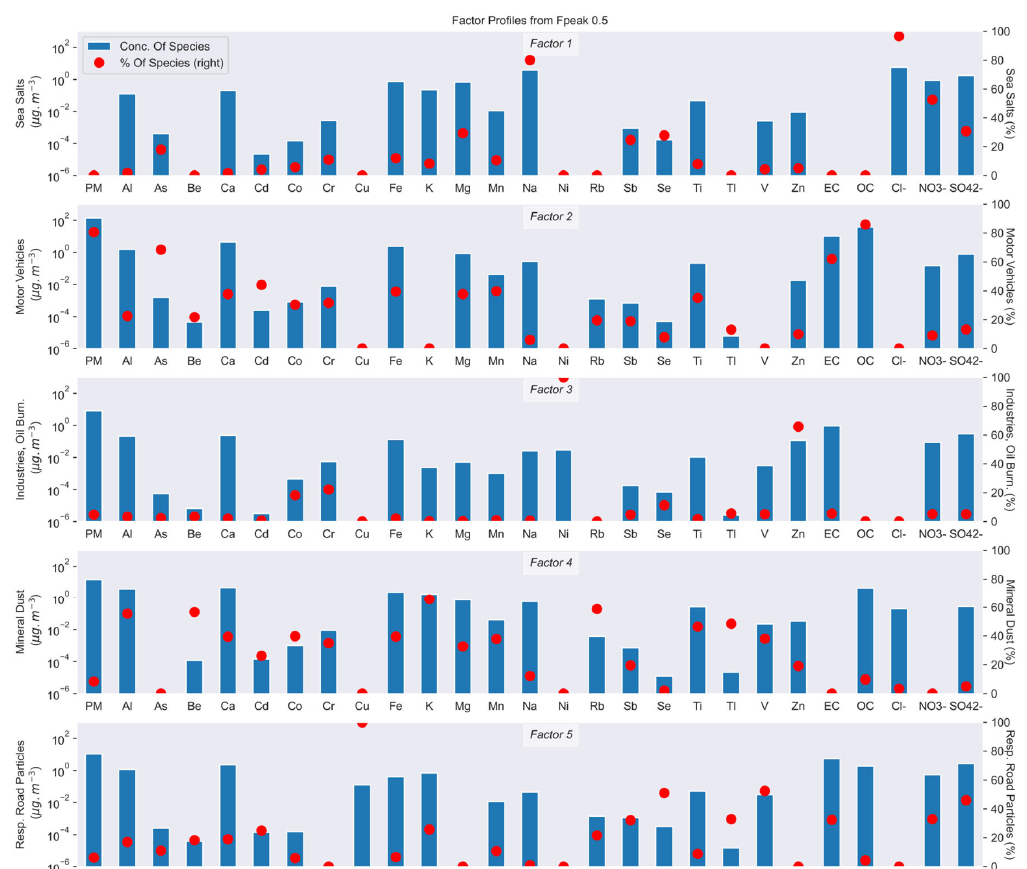
Figure 7. Pro fi les of the fi ve factors identi fi ed by the PMF in